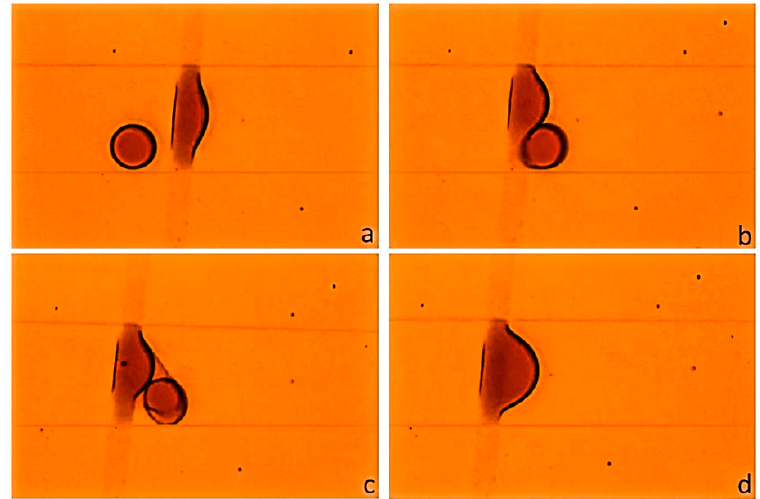
Figure 4. Droplet coalescence process in a microfluidic channel with patterned GO. ( a ) Droplet wetting the GO band, ( b ) subsequent droplet in contact with the droplet wetting the GO surface, ( c ) A bridge was formed between the droplets, ( d ) coalescence of droplets. The dimensions of the channel (W × H) are 200 µm × 50 µm. The width of the GO band is approximately 30 µm.